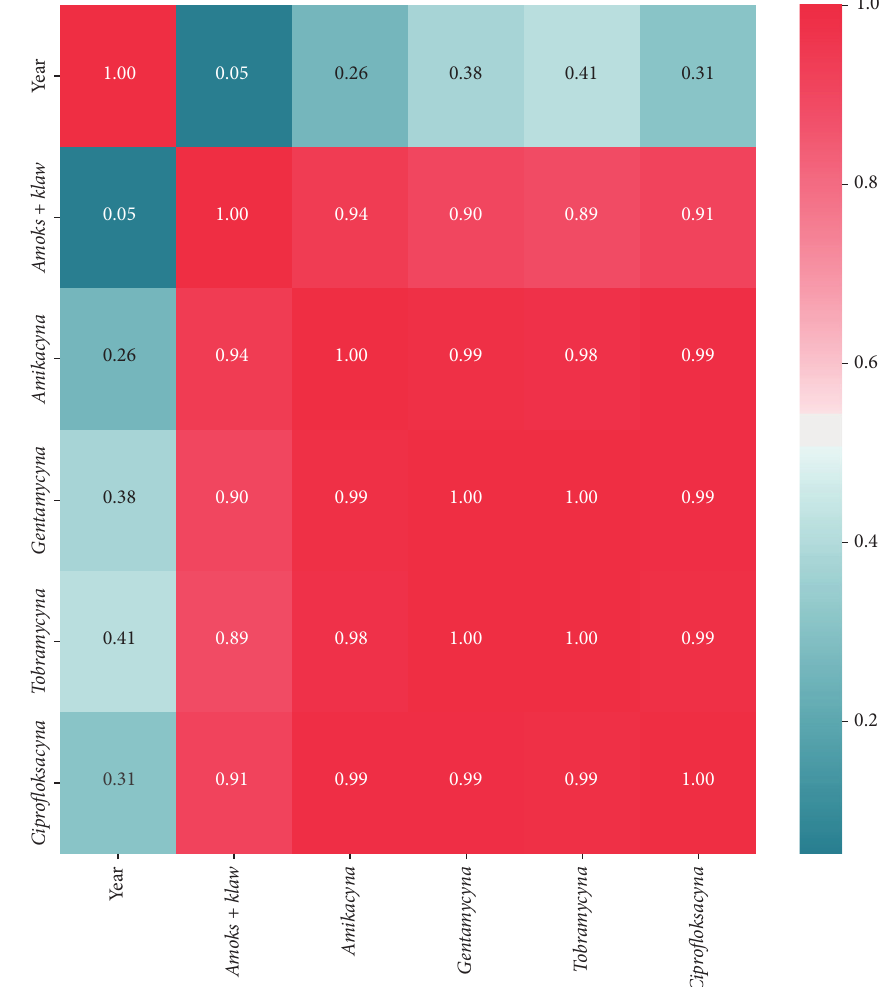
Figure 8: The matrix of Spearman’s correlation coefficients between antibiotics.